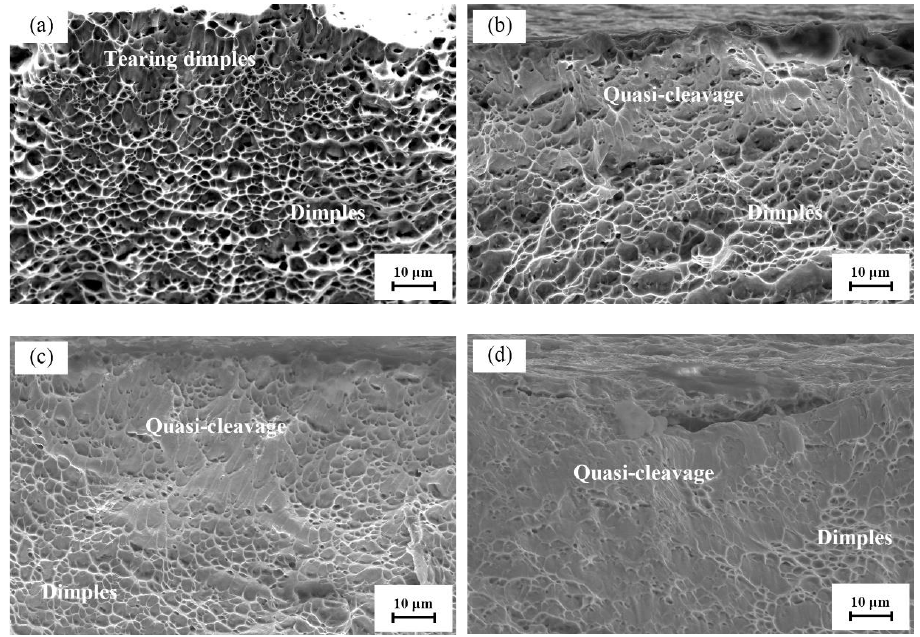
Figure 11. Fracture surface morphologies of 1 h charged Ti6Al4V alloy after SSRT under different HPs: ( a ) 0.1 MPa; ( b ) 10 MPa; ( c ) 30 MPa; ( d ) 50 MPa.